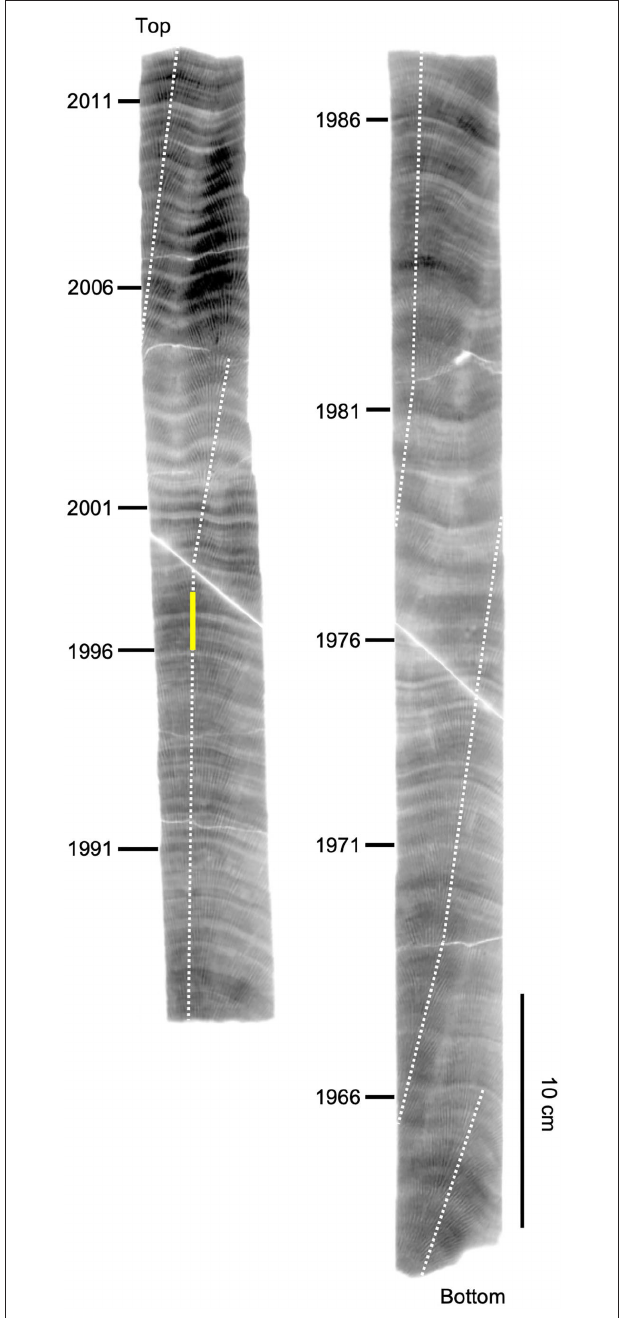
FIGURE 3 | X-radiograph of core BAL13-09. The dotted white line represents the micro-sampling array; the yellow portion corresponds to cool event in 1996–1997.